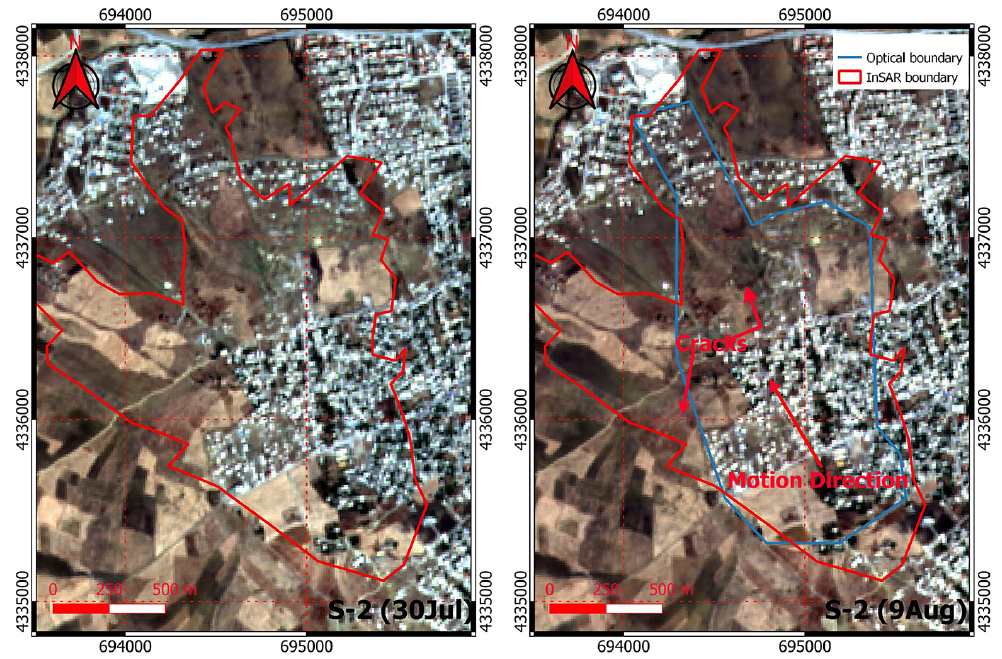
Figure 16. Sentinel-2 optic images: (a) dated 30 July 2020 and (b) dated 9 August 2020.